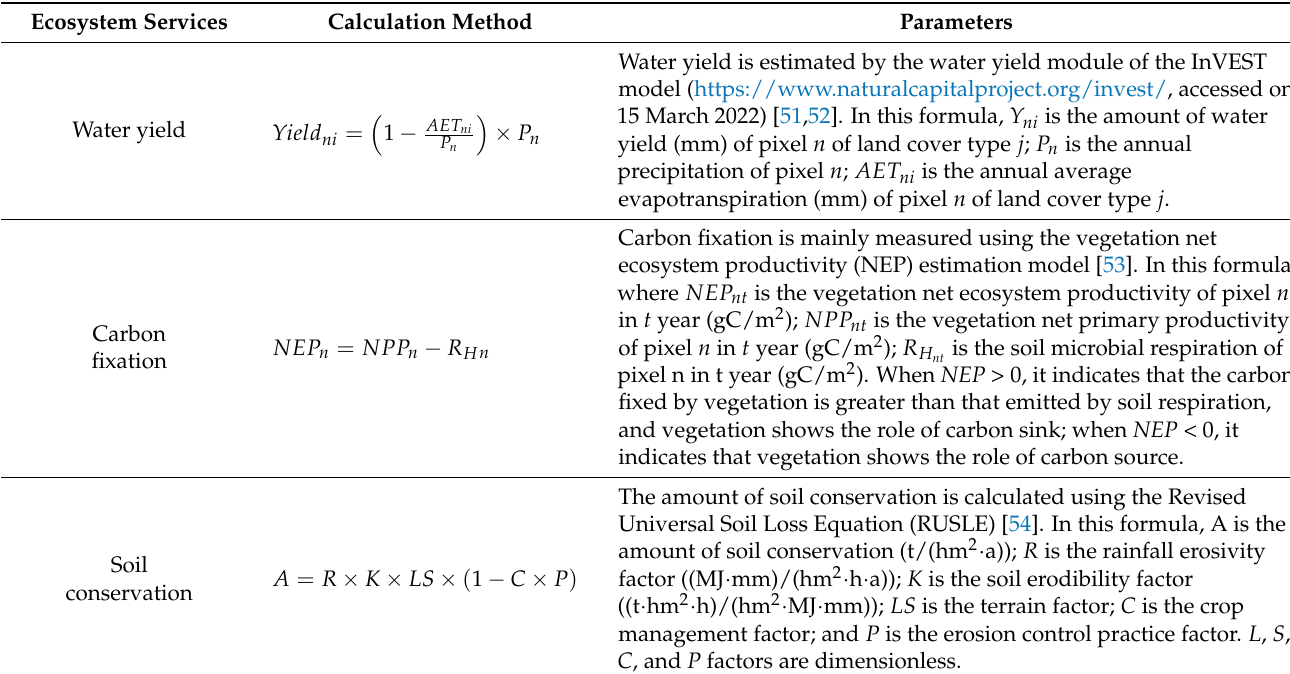
Table 3. Method and calculation process of ecosystem